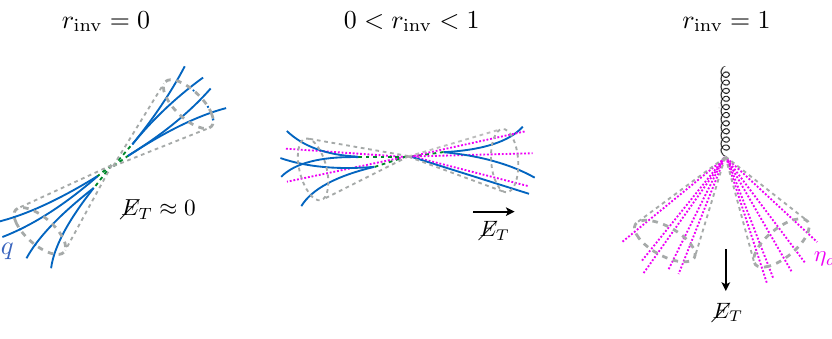
Figure 4 . Illustration of the typical missing energy direction for several di(cid:11)erent r